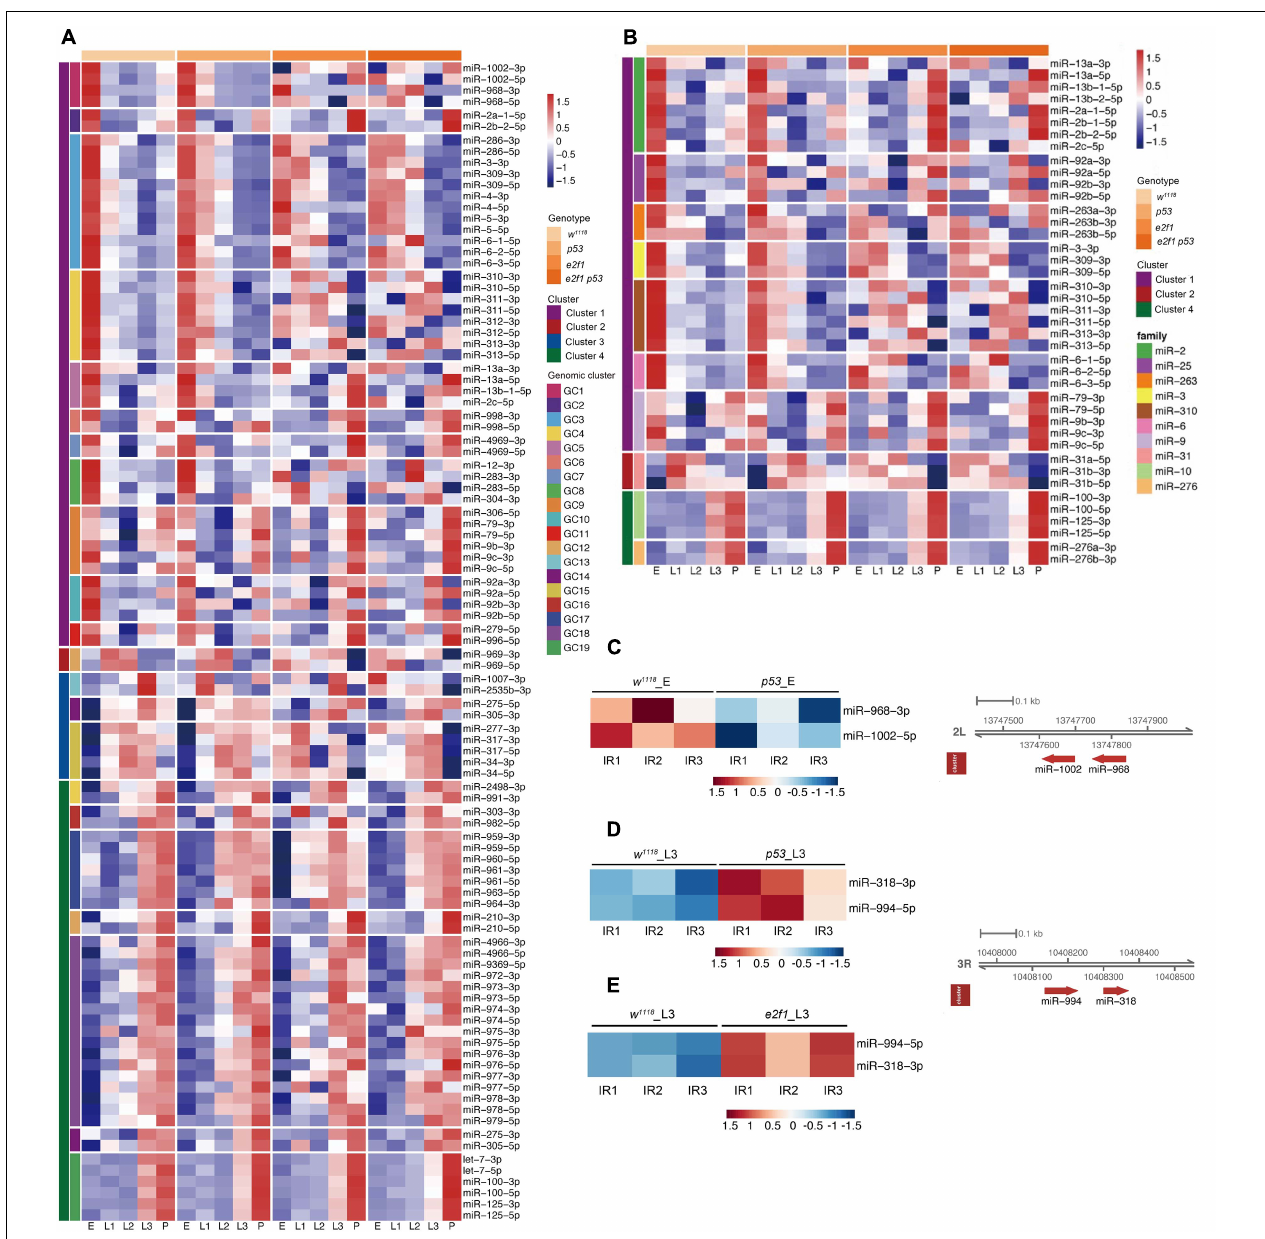
FIGURE 6 | Expression of miRNA genomic clusters and families during development and after X-ray irradiation. (A) Heatmap of miRNA genomic clusters during development. (B) Heatmap of miRNA families during development. (C) Heatmap of DE miRNA clusters after X-ray irradiation in p53 mutant embryos. (D) Heatmap of DE miRNA clusters after X-ray irradiation in p53 mutant L3. (E) Heatmap of DE miRNA clusters after X-ray irradiation in e2f1 mutant L3.